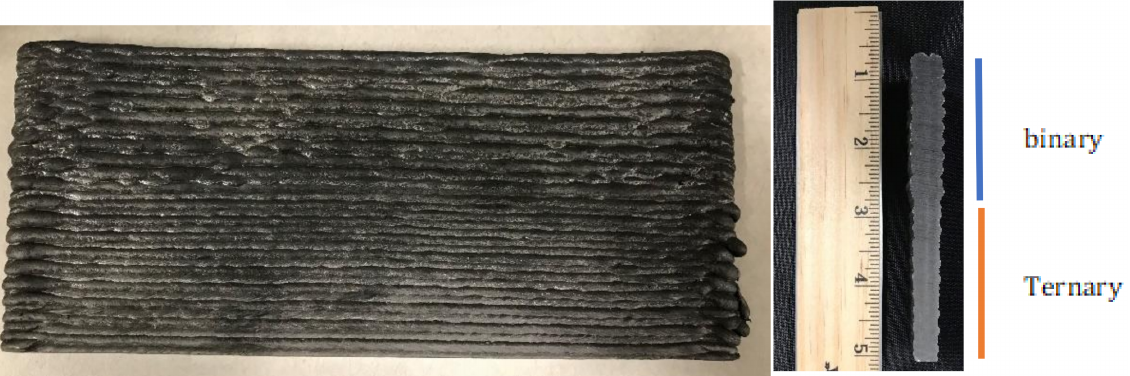
Figure 8. Side and cross-sectional views of wall deposited by altering the shielding gas from ternary blend to binary blend midway through the